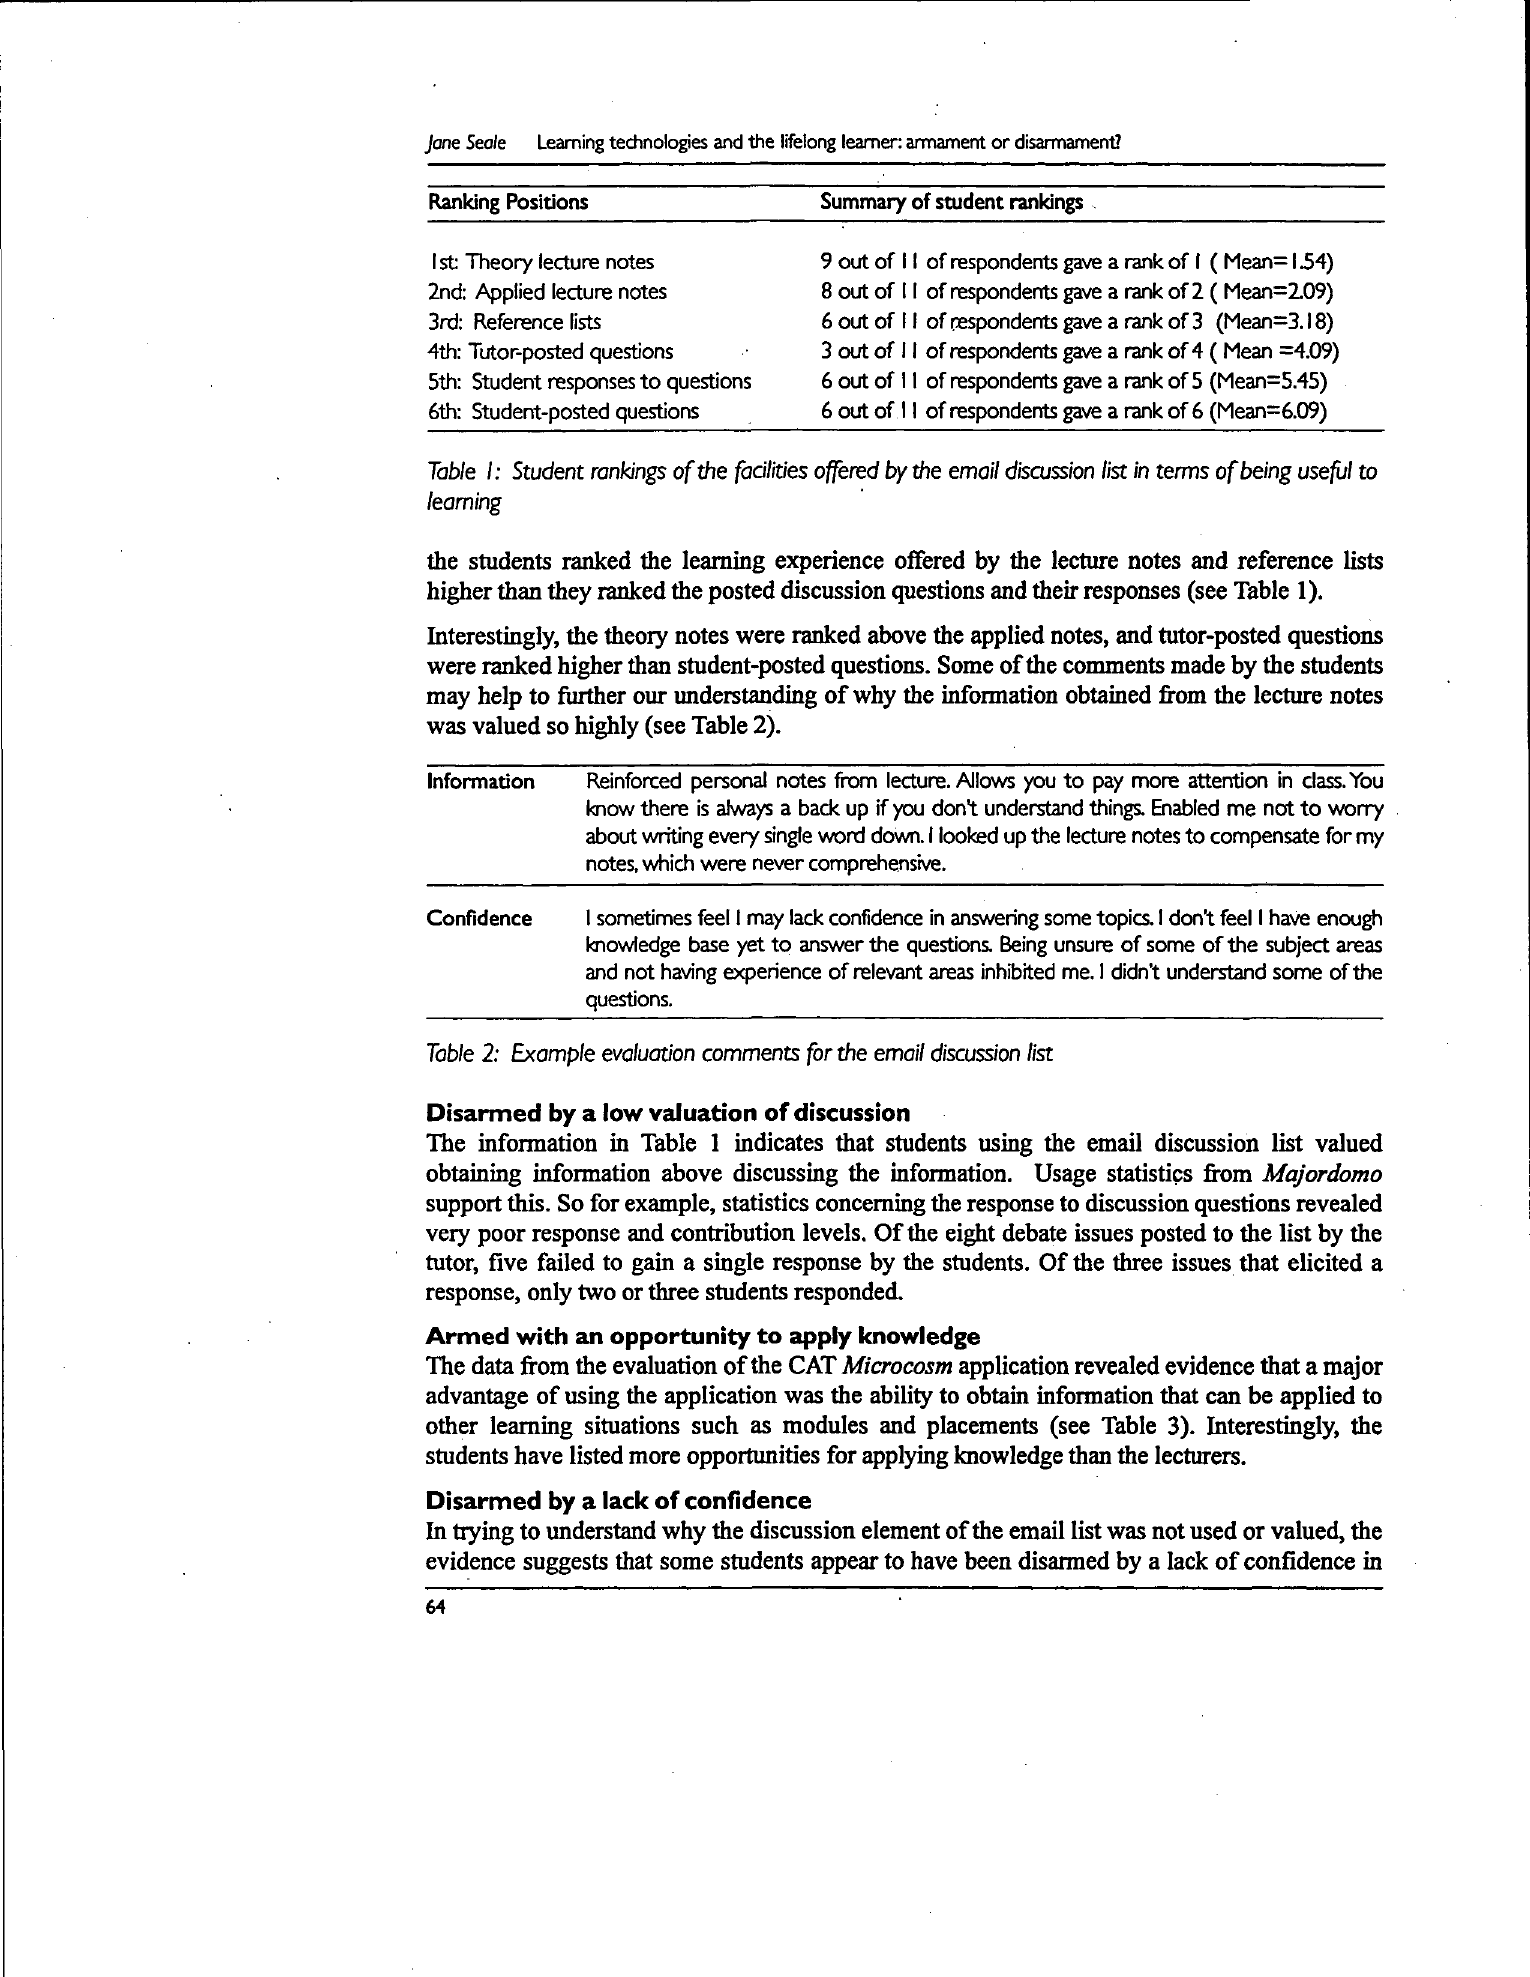
Table I: Student rankings of the facilities offered by the email discussion list in terms of being useful to learning